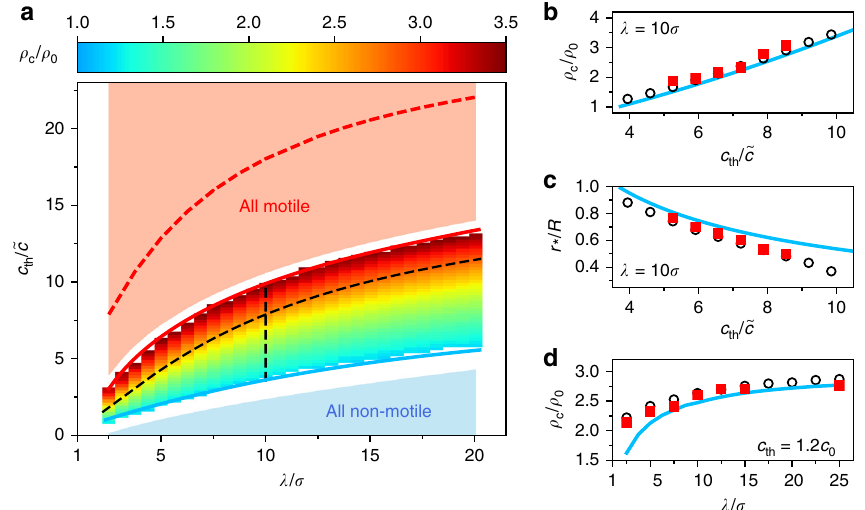
Fig. 3 Phase behaviour. a Numerically determined phase diagram showing the dependence of the cluster density ρ c on the threshold c th and interaction length λ . Clustering occurs between the two solid lines (blue line: minimal threshold from theory, red line: limit of cluster stability), outside the system is homogeneous. Shaded areas indicate regions where all particles are either motile (red) or non-motile (blue). Red dashed line: theoretical limit where the cluster density reaches close packing. Black dashed lines correspond to paths along which experimental data were taken. b Cluster density ρ c and c cluster radius r * as a function of threshold c th at λ = 10 σ (vertical dashed line in a ). d Cluster density as a function of decay length λ , holding the threshold c th = (cid:3) (cid:4) e (cid:2) σ = λ (cid:2) e (cid:2) R = λ 1.2 c 0 constant with respect to the reference concentration c 0 ð λ Þ ¼ γλρ 0 of a (hypothetical) homogeneous system (horizontal dashed line 2 D c in a ). In b – d , open symbols correspond to simulations, closed symbols to experiments and blue lines to theory. Experimental error bars (standard deviation) are comparable to the symbol con fi guration (Fig. 3d and Supplementary Figure 3). The upper- boundary for cluster formation suggested by mean- fi eld theory is shown as a dashed red line and largely overestimates the limit where stable clusters are formed according to our experimental and numerical data. The reason is that clusters shrink as we increase the threshold, and clusters composed of a few particles become unstable with respect to fl uctuations (which are neglected in mean- fi eld). A small density fl uctuation (e.g. because one particle leaves the cluster) might lead to a drop of the chemical concentration below the threshold for other particles in the cluster, which then become motile and also leave the cluster.